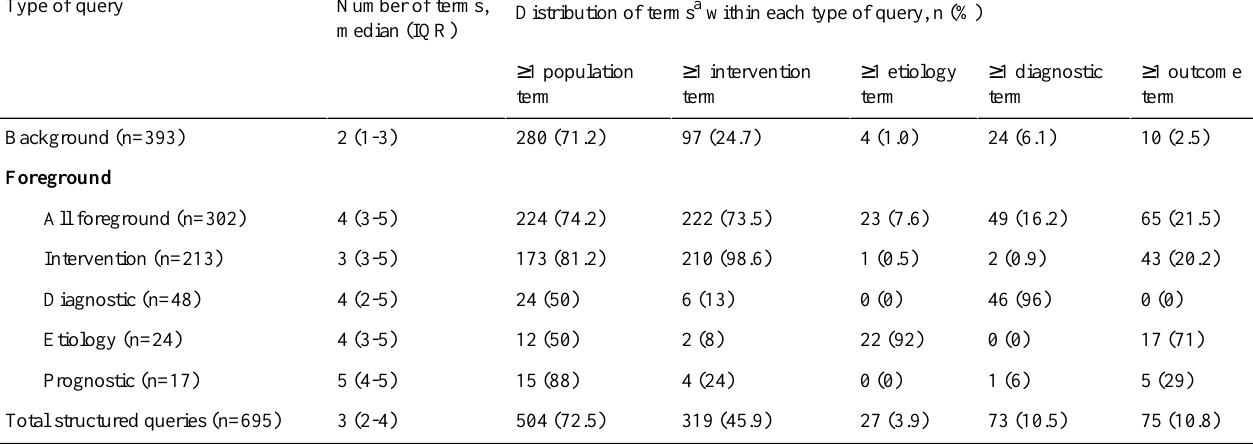
Table 3. Number of terms with respect to type of structured queries.